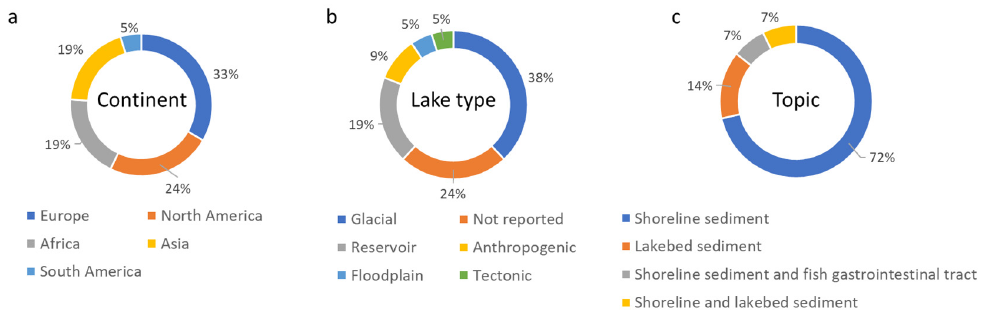
Figure 4. Frequency of investigated articles by ( a ) continent; ( b ) lake type; ( c ) topic.